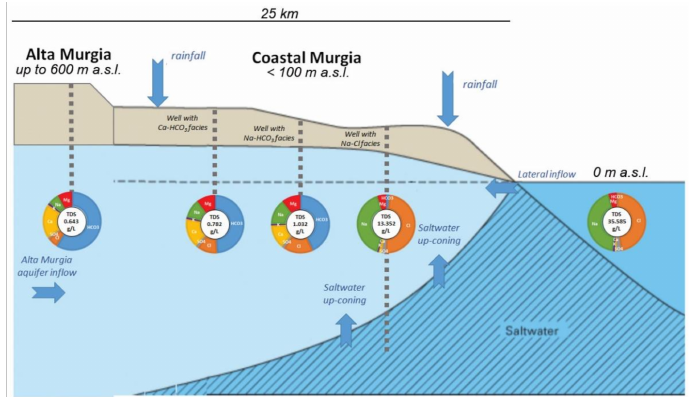
Figure 8. Schematic conceptual model (not in scale) of the investigated area. In the doughnut charts: blue = HCO 3 − , orange = Cl − , grey = SO 4 2 − , yellow = Ca 2+ , purple = K + , green = Na + , red = Mg